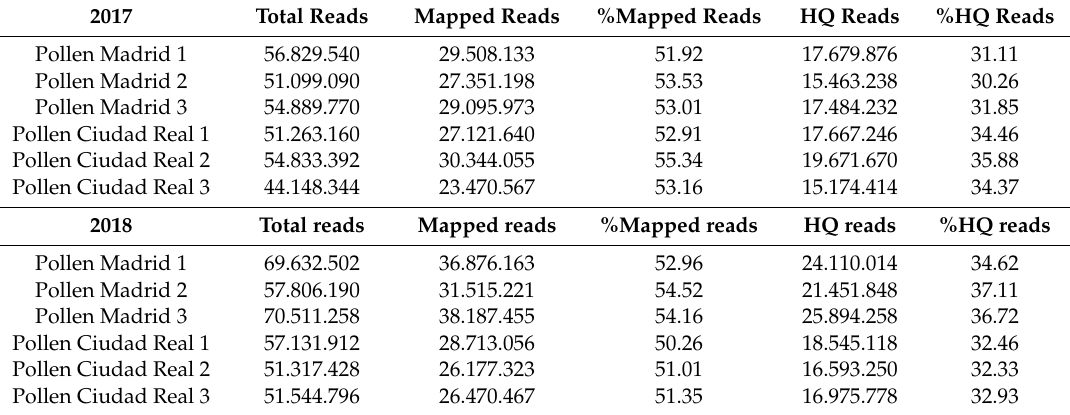
Table 1. Total, mapped, and HQ (High Quality) reads of the three di ff erent replicates from pollen from Madrid and Ciudad Real in the two sampling moments, 2017 and 2018.